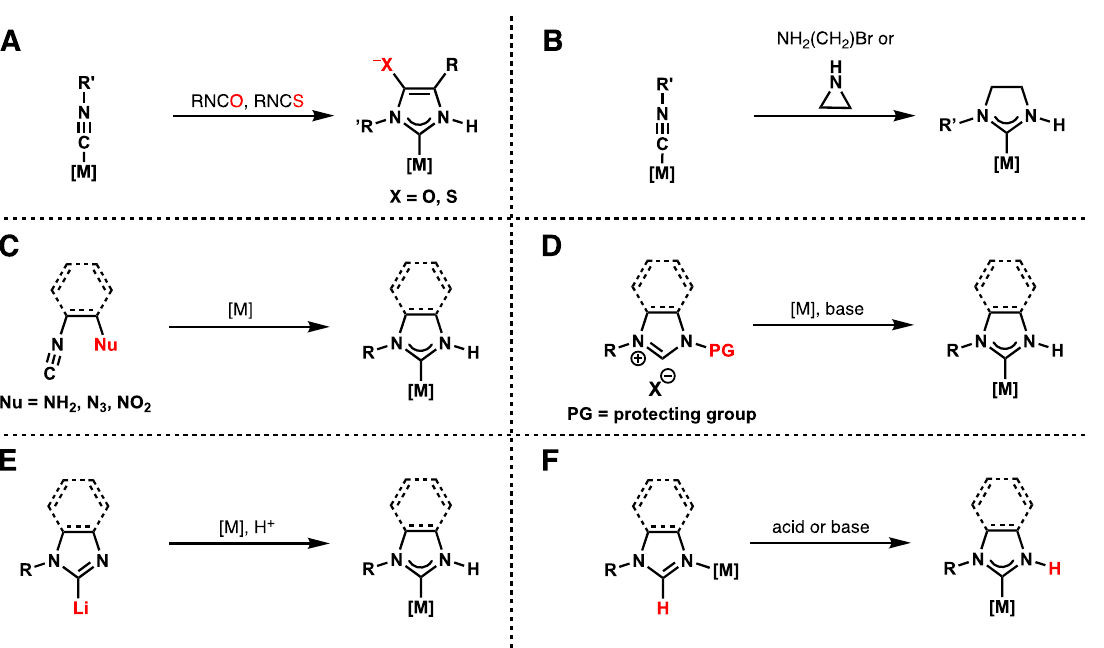
Scheme 2. Synthetic strategies for the preparation of protic NHC complexes: ( A ) metal-templated cyclization of isocyanides and nitrogen-containing nucleophiles; ( B ) metal-templated cyclisation of isocyanides with bromoethylamine or aziridine; ( C ) intramolecular metal isocyanide 1,2-addition;